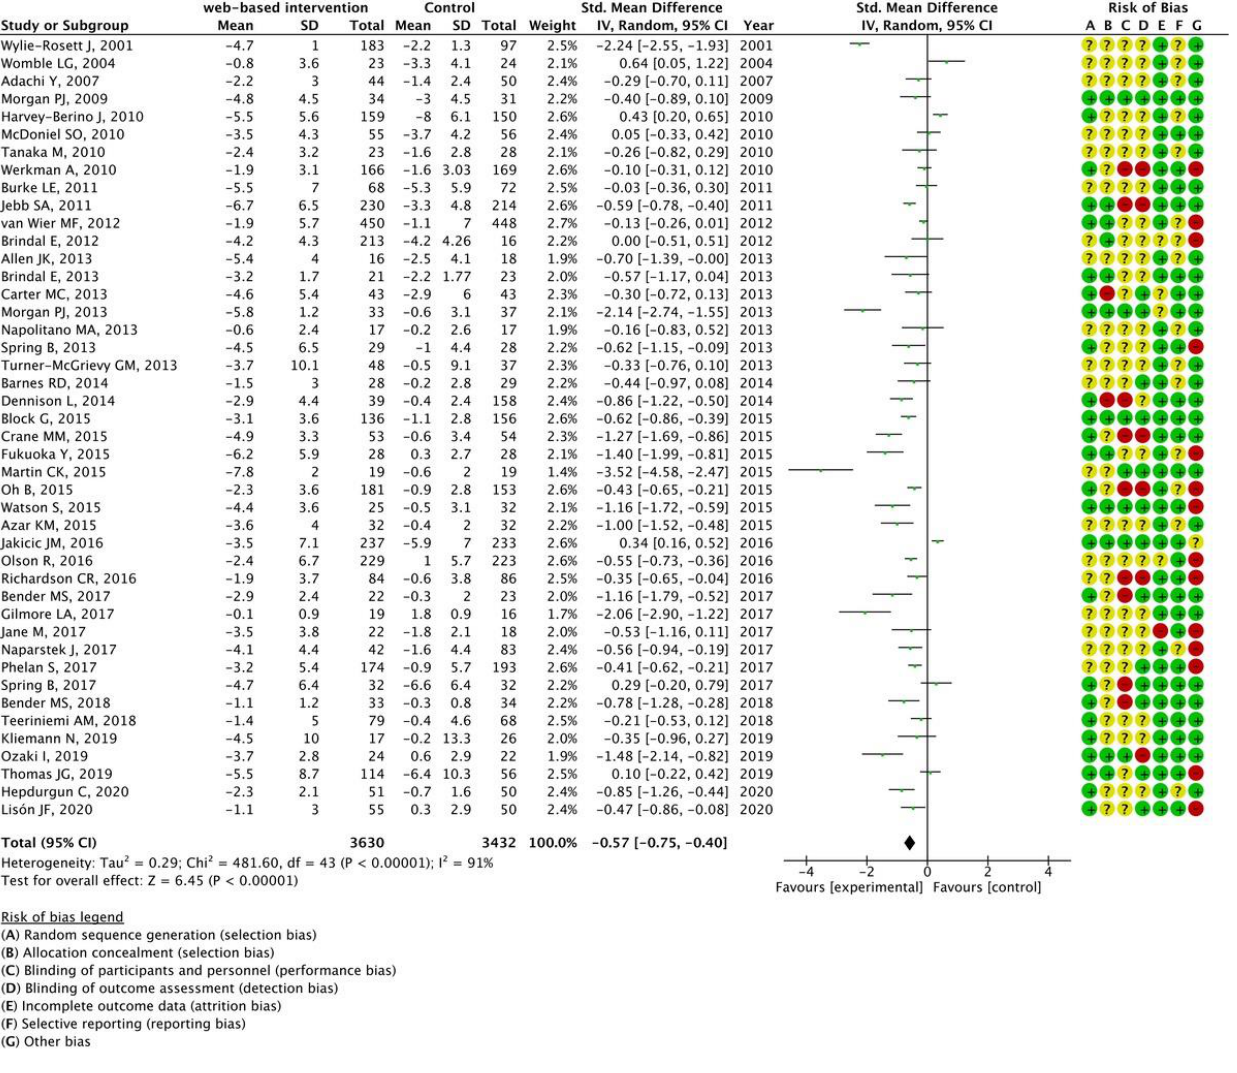
Figure 3. Meta-analysis for mean weight change comparing web-based interventions with offline control groups using 44 articles [12,13,15,17,20 – 30,32 – 47,49 – 56,58 – 62]. The forest plot shows standardized mean differences (SMD) for each article with 95% confidence intervals (CI). The diamond at the bottom of the graph means the meta-analyzed measure of effect and the lateral points of which indicate CIs for this estimate. A positive value reflects web-based interventions are more effective for weight loss than offline interventions. The area of each green square is proportional to the study's weight in the meta-analysis.